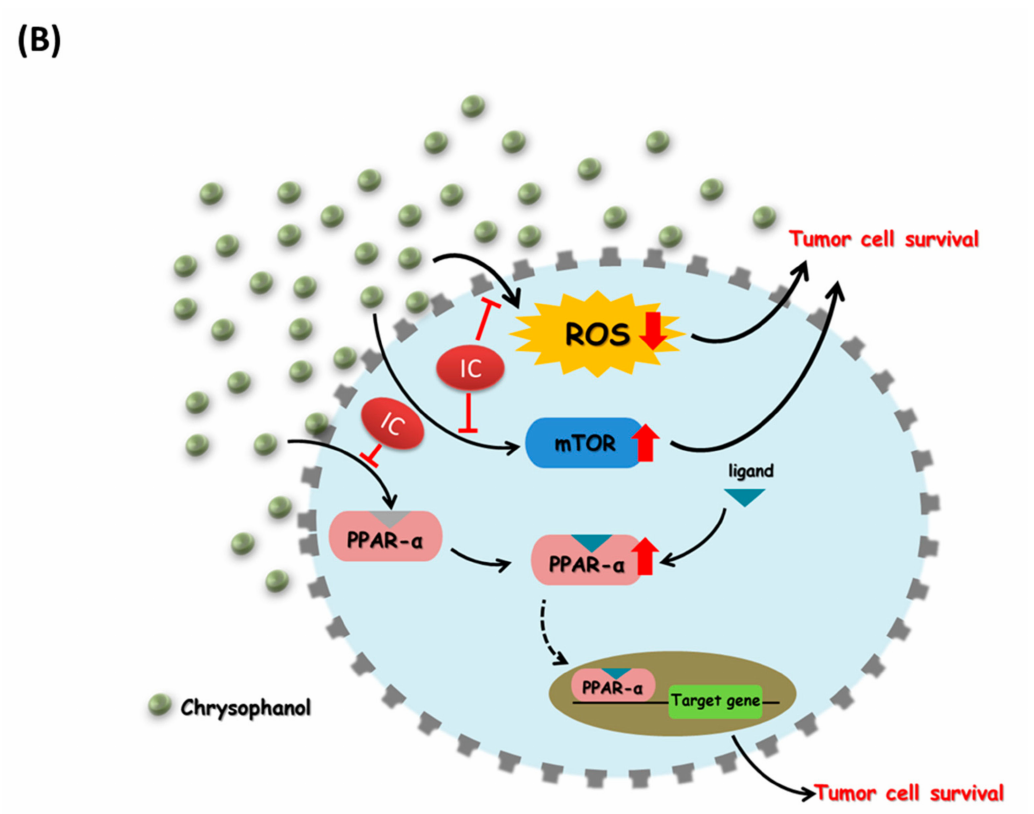
Figure 5. Schematic diagram of chrysophanol and its role in regulating tumoricidal death in SAS cells. ( A ) Chrysophanol-induced tumoricidal death via increased ROS accumulation and decreased mTOR/PPAR- α expression. ( B ) Iron chelator (IC; DFO and Lipro were used in this study) attenu- ated chrysophanol-induced tumoricidal death and caused tumor cell survival via decreased ROS accumulation and increased mTOR/PPAR- α